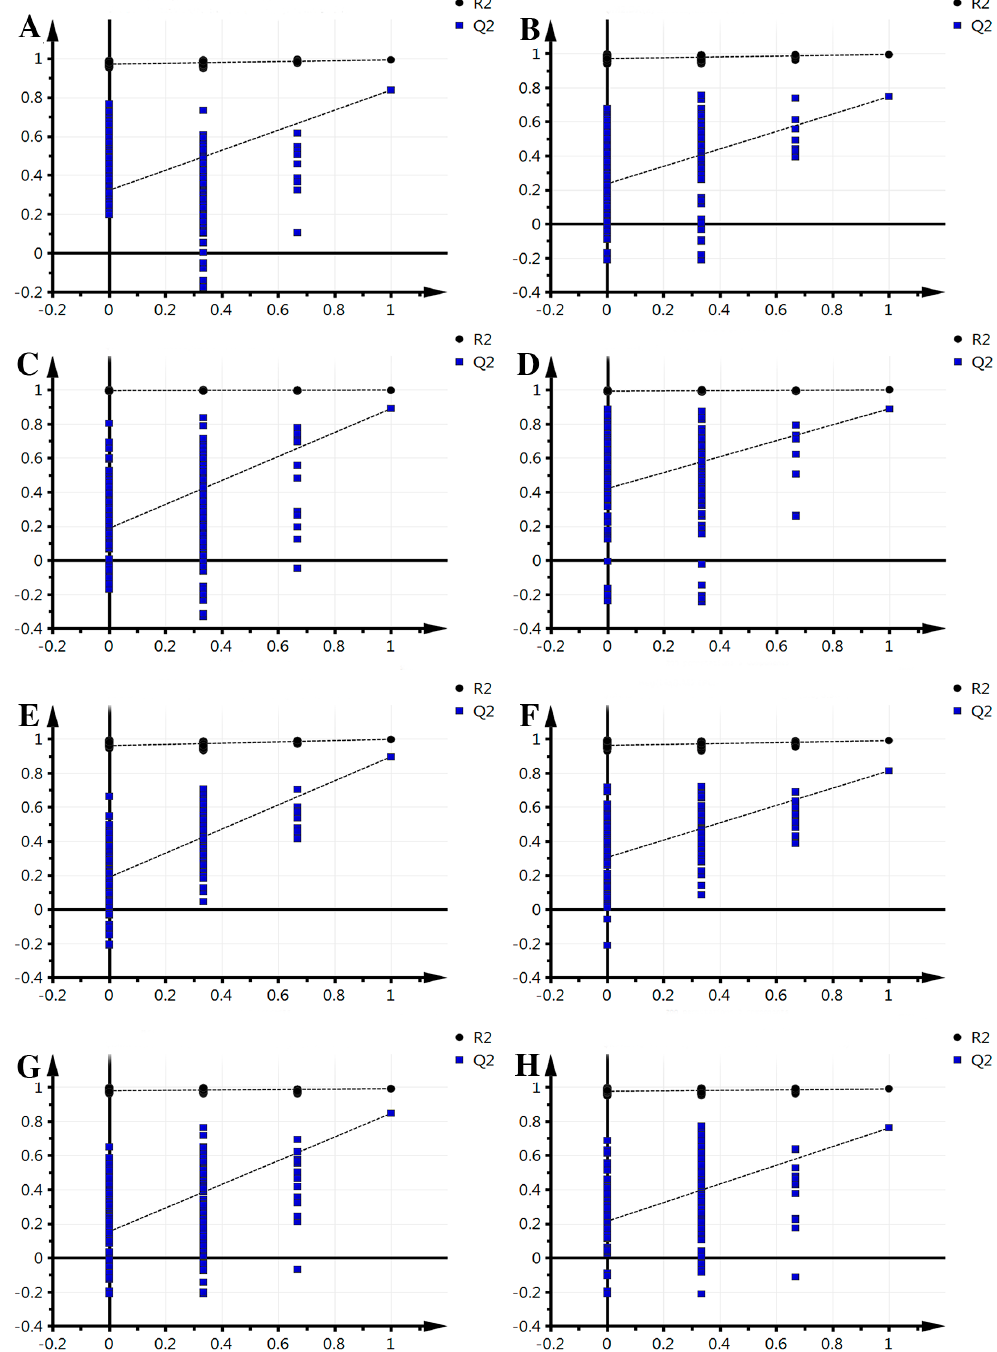
Figure 2. Effective verification of fresh-cut Chinese water chestnut during different storage times. ( A ) 0–2 comparison, ESI+; ( B ) 2–3 comparison, ESI+; ( C ) 3–4 comparison, ESI+; ( D ) 4–5 comparison, ESI+; ( E ) 0–2